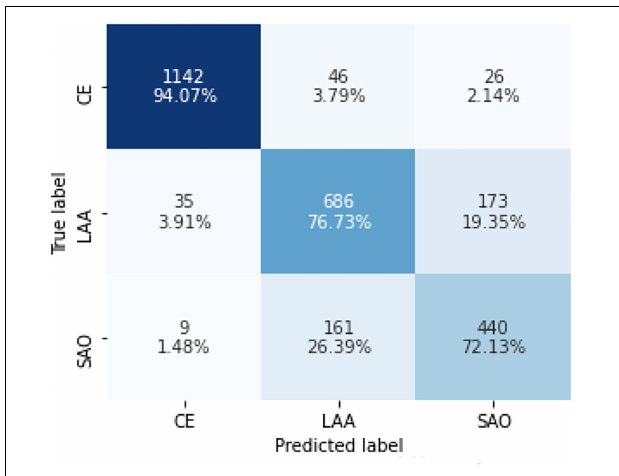
FIGURE 4 | Confusion matrix of the model in identifying CE, LAA, and SAO on the test set. CE, cardioembolism; LAA, large-artery atherosclerosis; SAO, small-artery occlusion. Confusion matrices are calculated by comparing the position and classification of each measured sample with the actual corresponding position and classification. Each column represents the predicted category of the data, and each row represents the true attribution